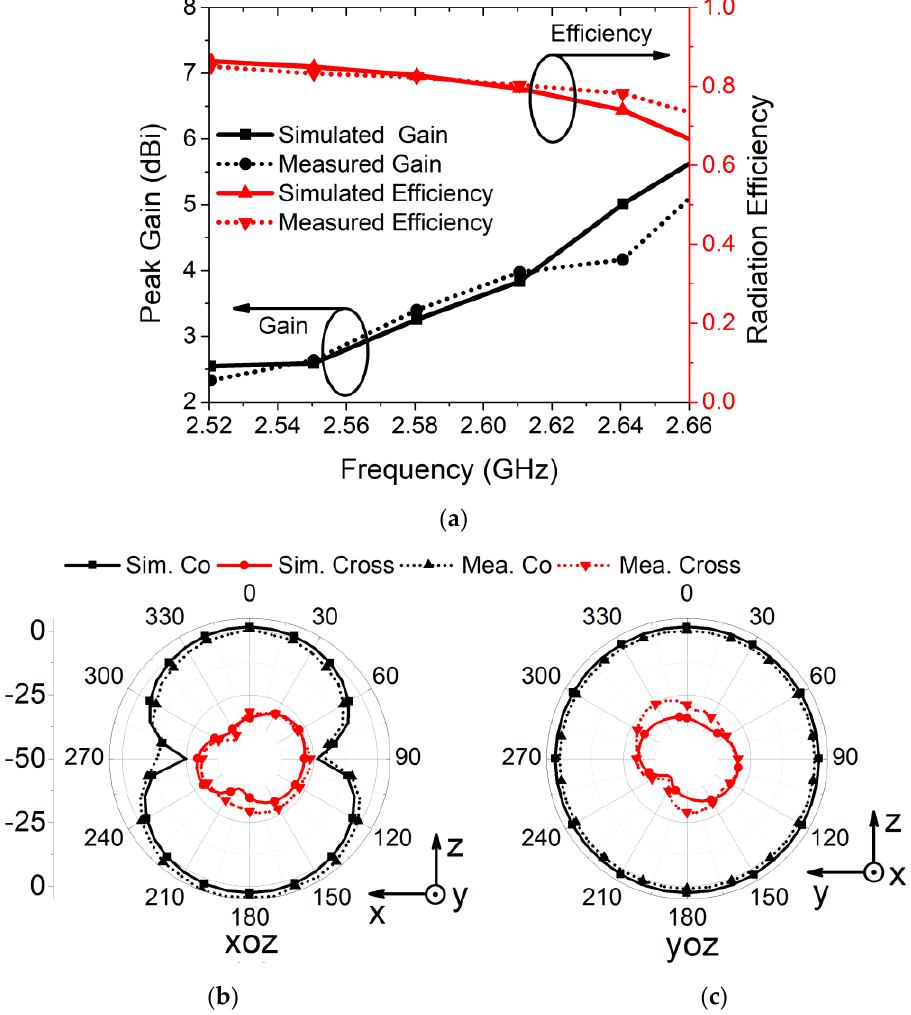
Figure 17. Simulated and measured results of ( a ) peak gain and radiation efficiency, ( b ) radiation pattern of xoz plane, and ( c ) radiation pattern of yoz plane.